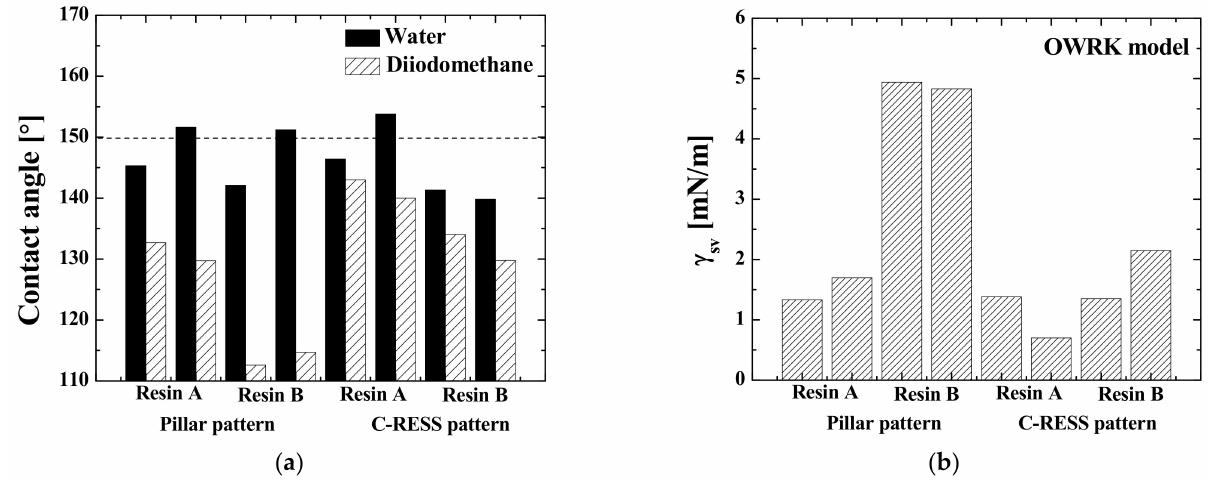
Figure 19. Effects of micro-structure pattern and resin type on the surface properties ( a ) water and diiodomethane contact angle and ( b ) surface free energy of the imprinted micro-structures.